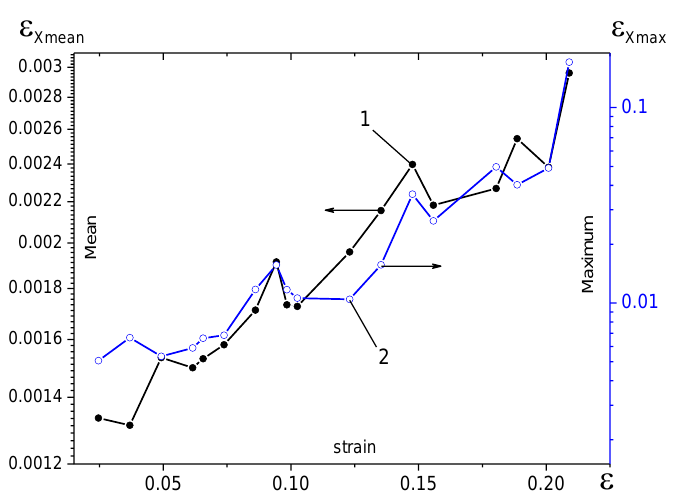
Figure 13. Dependences of the average (1) and maximum (2) of longitudinal deformation component versus strain ε